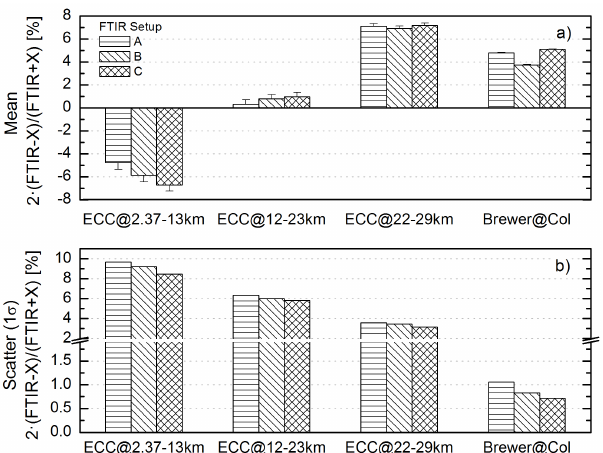
Fig. 9. Relative differences [%] between the ozone partial columns (2.37–13km, 12–23km and 22–29km) calculated from the ECC sonde and from the different FTIR setups: (a) mean values (error bars indicate the standard error of the mean) and (b) scatter or stan- dard deviation (1 σ ). It is also shown the differences between the FTIR and Brewer ozone columns. X means the ECC or Brewer